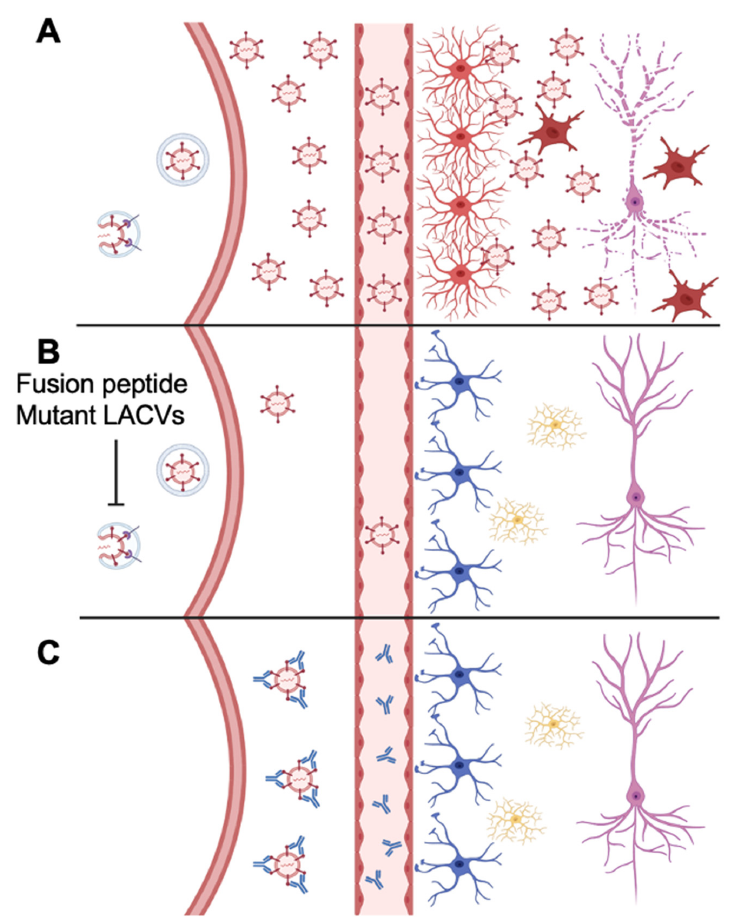
Figure 6. Model of neuroprotection for rLACV rechallenge. ( A ) WT LACV or WT rLACV robustly replicates in muscle resulting in viremia. Virus enters the CNS causing neurologic disease characterized by neuronal damage, reactive astrocytes, and activated microglia. ( B ) Fusion peptide mutants rLACVs replicate to a lower level in muscle resulting in less virus in the CNS and decreased neurologic disease. ( C ) After infection with fusion peptide mutant rLACVs, neutralizing antibodies are produced, which decrease replication of WT LACV in the muscle after rechallenge preventing virus from entering the CNS and preventing neurologic disease.